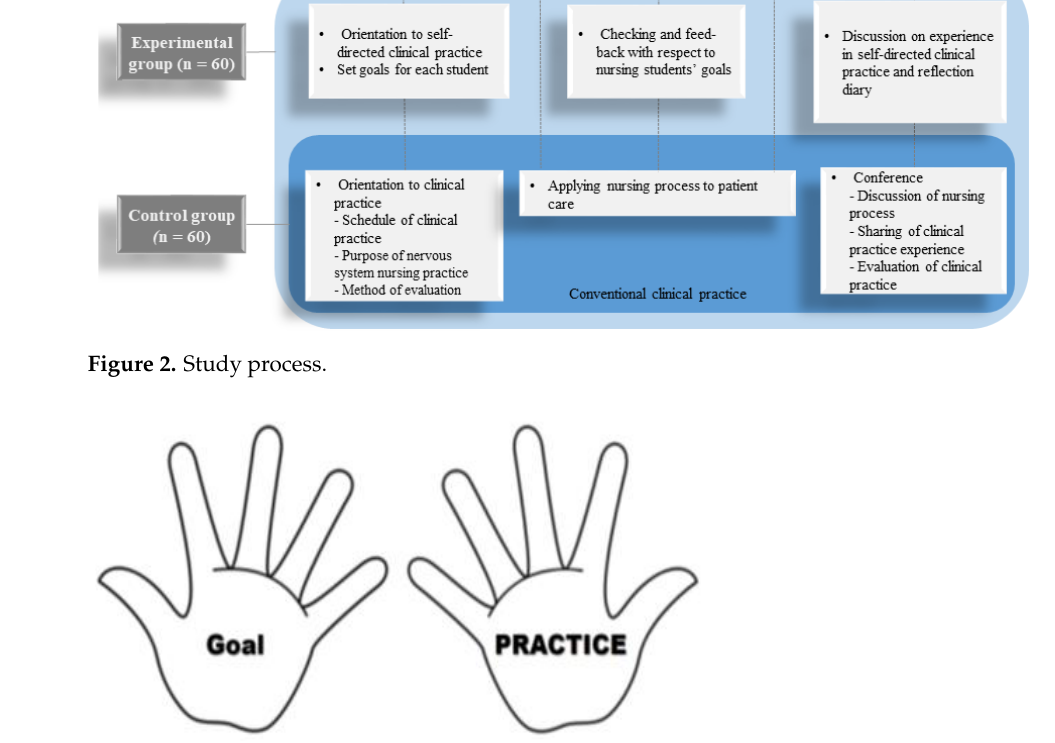
Figure 3. Sample of finger illustration.